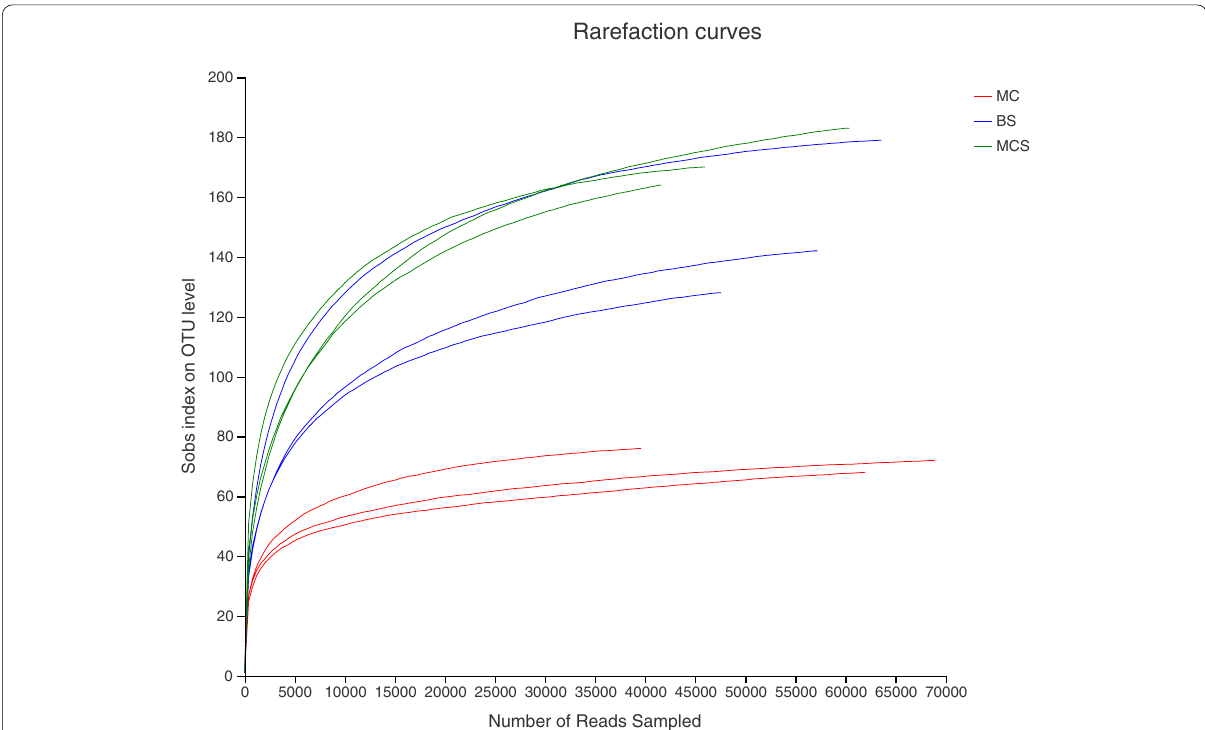
Fig. 1 Rarefaction curves between different amounts of biochar added. Notes: MC, BS, and MCS represent the biochar addition amount of 0 t/m 3 , 10 t/m 3 , and 20 t/m 3